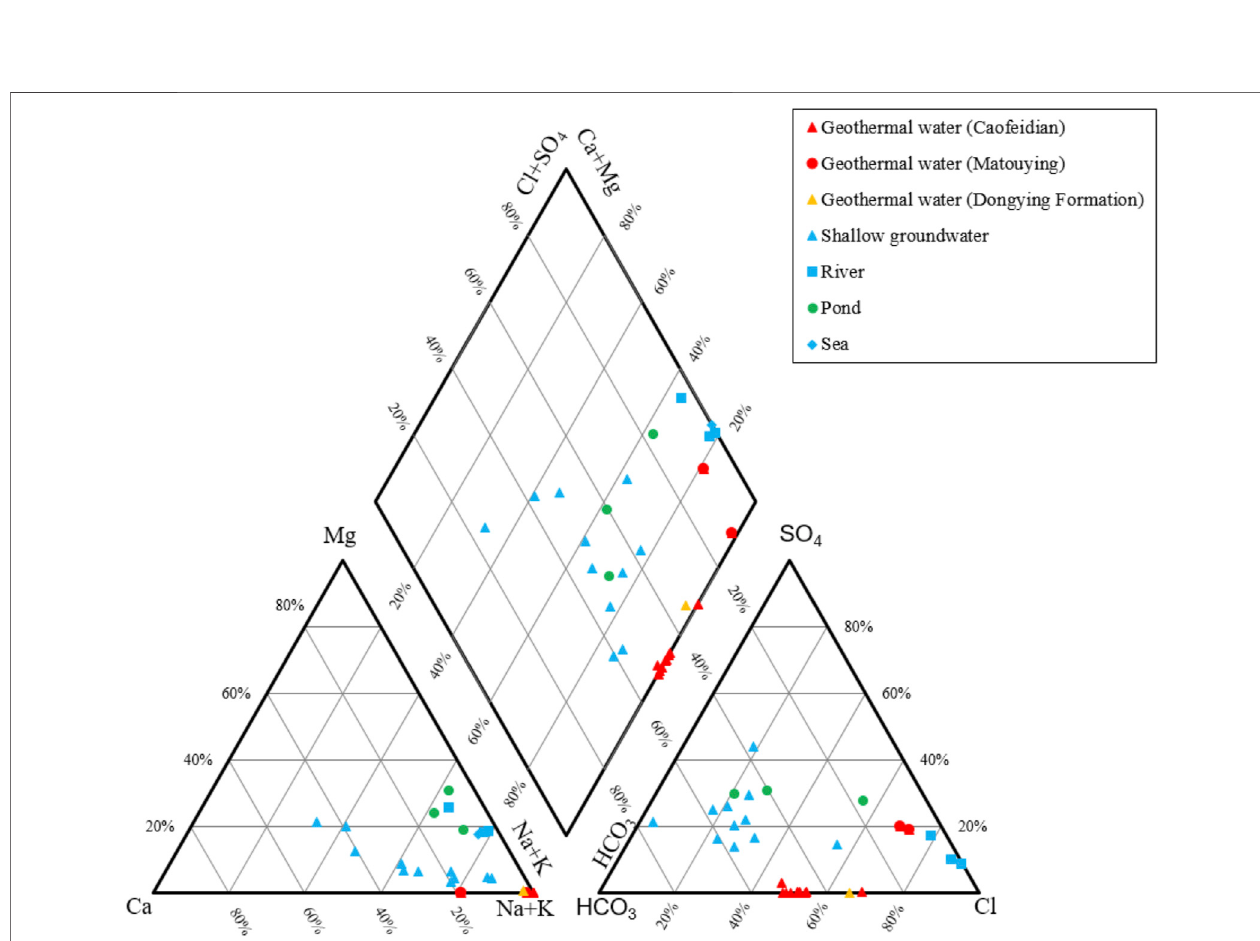
FIGURE 6 | Piper diagram of different water bodies around geothermal sites.